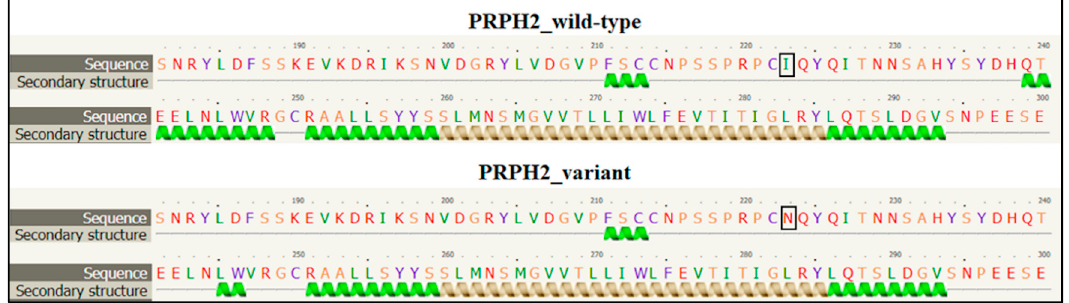
Figure 3. Section of the secondary structure predicted by Phyre2 tool in wild-type and variant PRPH2 sequence. The black square indicates the position of the amino acid change. The figure shows the disruption of the α -helical structure between the residues 239 and 250 in the variant PRPH2 with respect to the wild-type. The other residues reporting the altered secondary structure are not shown.